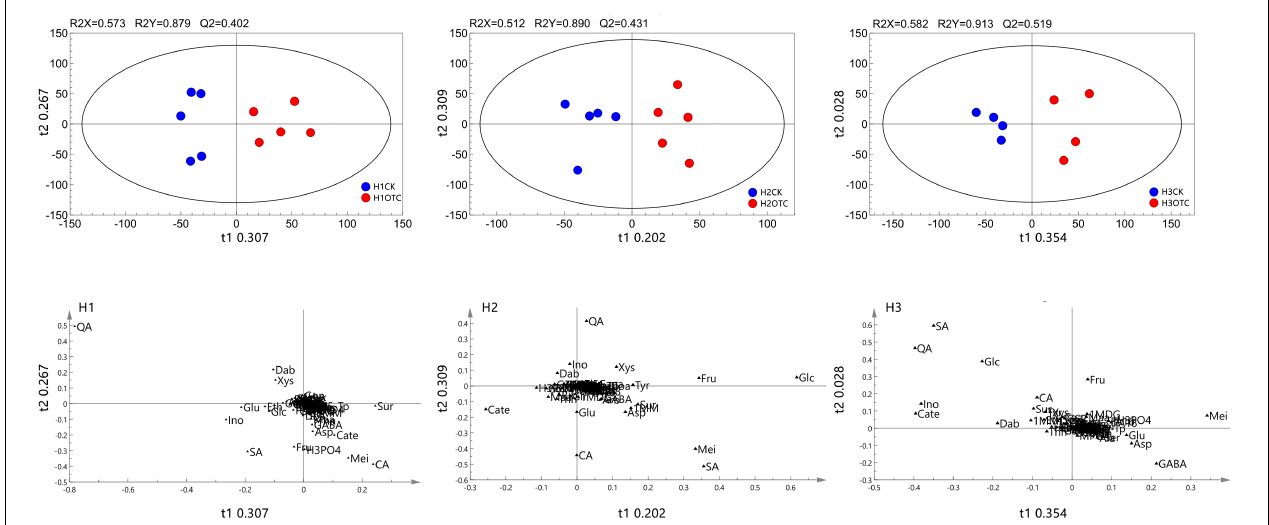
FIGURE 4 | Score plots and loading diagram of orthogonal partial least squares discrimination analysis (OPLS-DA) metabolic profiles in the needles of A. faxoniana at 3,500, 3,000, and 2,600 m under controls and OTCs. H1, the altitude of 3,500 m; H2, the altitude of 3,000 m; H3, the altitude of 2,600 m.